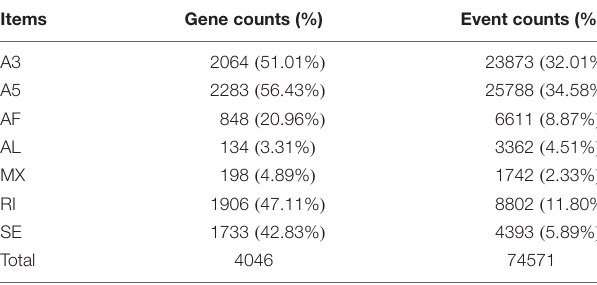
non-redundant transcripts of abdominal and subcutaneous adipose in NT, KOG, and Swiss-Prot